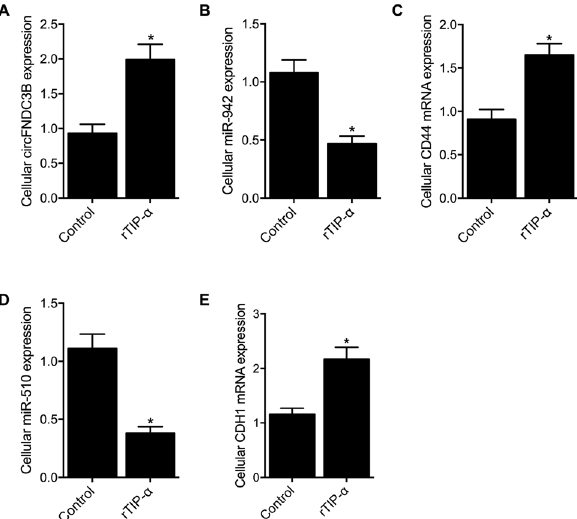
Figure 4. Influence of H. pylori infection upon the signaling pathway (* P value < 0.05 vs. control group). ( A ) CircFNDC3B expression was increased in the rTip-α group compared with the control group; ( B ) The level of miR-942 was suppressed in the rTip-α group compared with the control group; ( C ) Expression of CD44 mRNA was higher in the rTip-α group compared with the control group; ( D ) The level of miR-510 was suppressed in the rTip-α group compared with the control group; ( E ) Expression of CDH1 mRNA was higher in the rTip-α group compared with the control